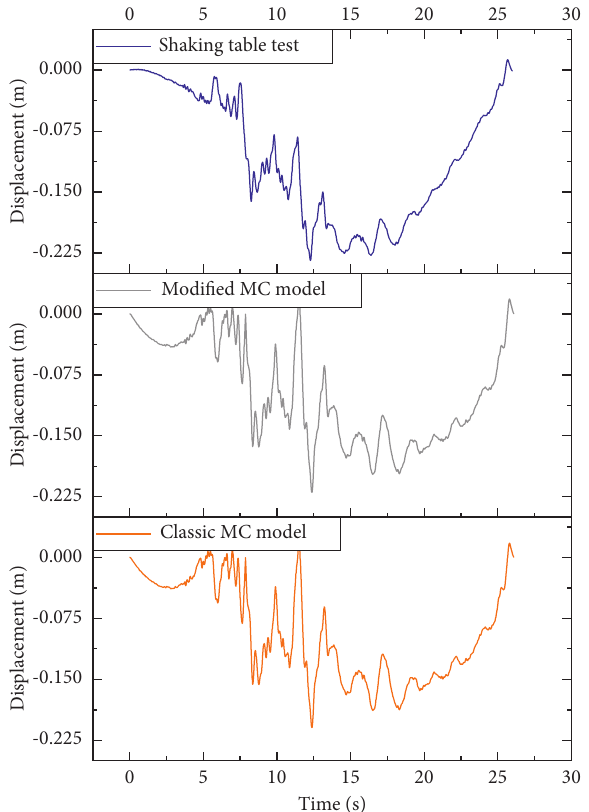
Figure 21: Displacement time history at point